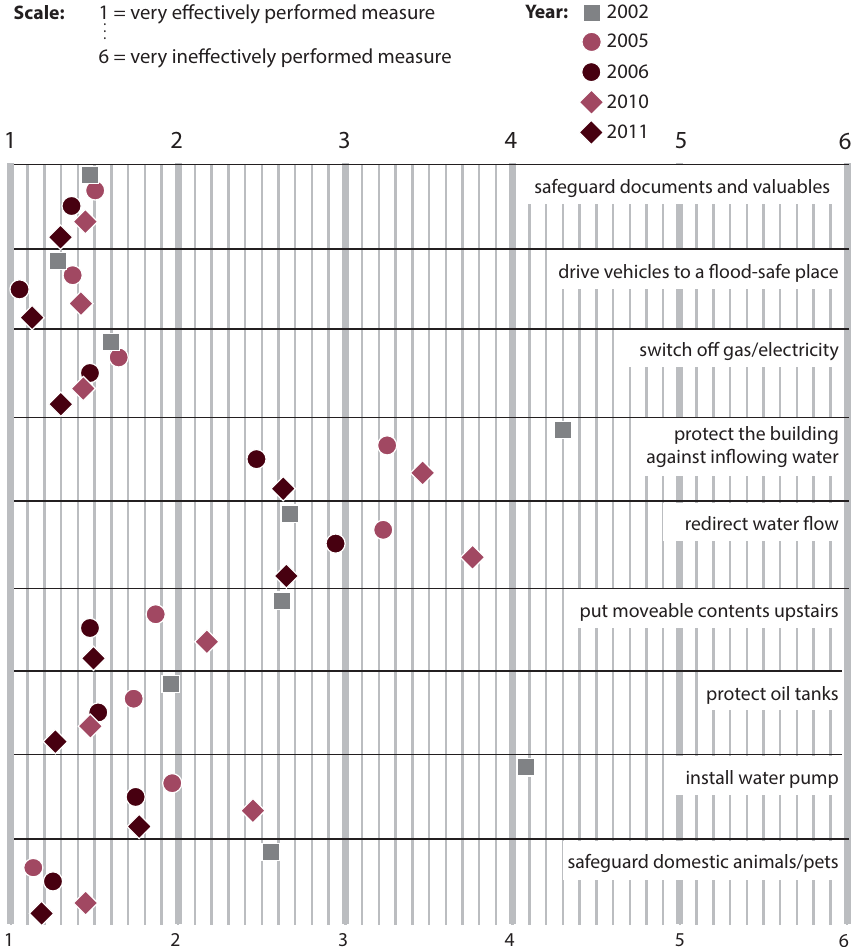
Figure 6. Average effectiveness of emergency measures as evaluated by the people interviewed on a scale from 1 (if measure was very effective) to 6 (if measure was very